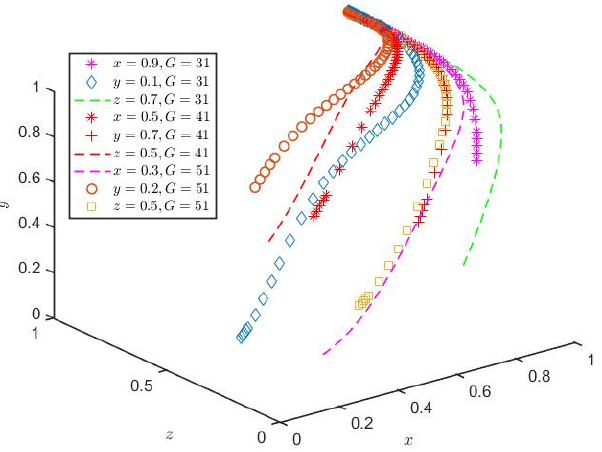
Figure 3. Effects of different accounts receivables on evolutionary game strategies.